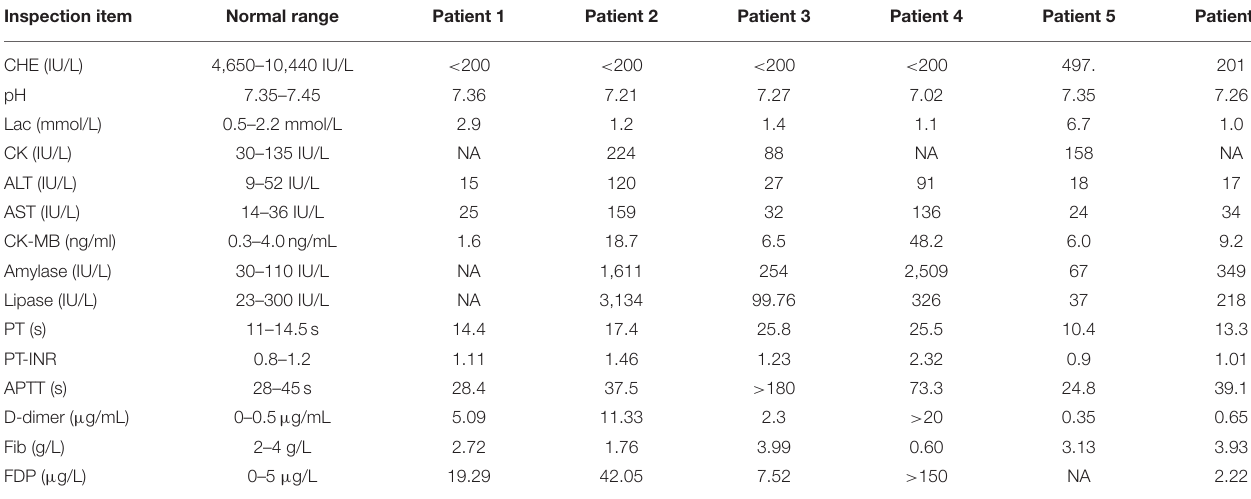
TABLE 2 | Main laboratory test results of six patients upon admission to our department. Inspection